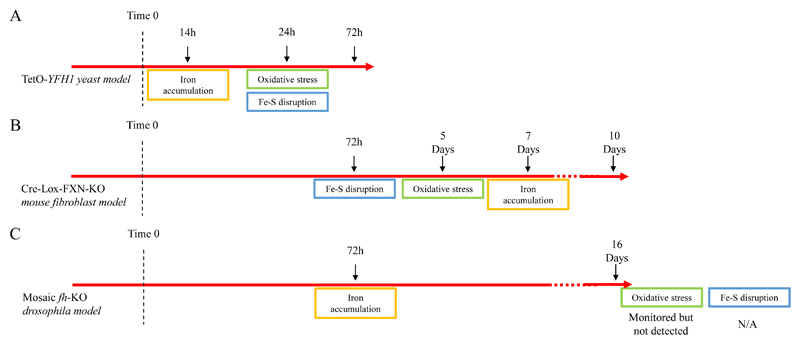
Summary of the outcomes found in the three different studies shown against a horizontal time.A) TetO-YFH1 yeast model9; B) Cre-Lox-FXN-KO mouse fibroblast model7; C) Mosaic fh-KO drosophila model8.